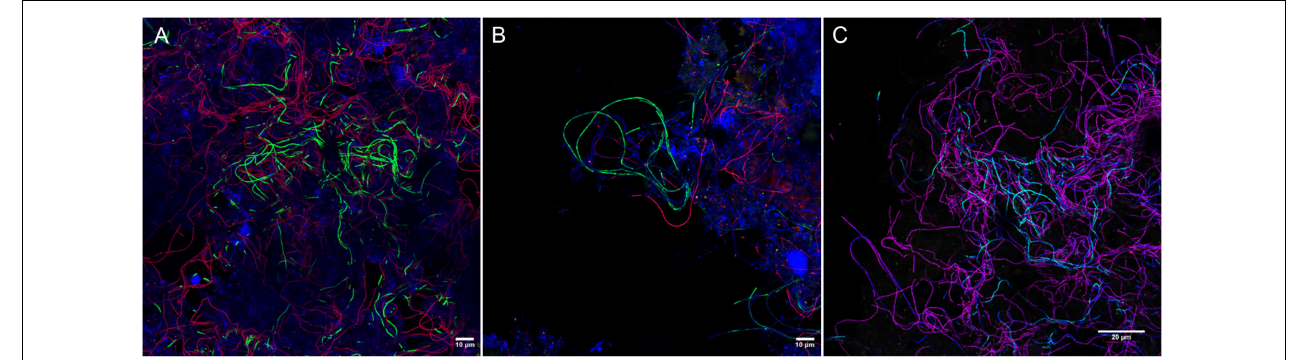
FIGURE 5 | Composite FISH micrographs of Ca. Microthrix species in full-scale activated sludge. (A) Ca. M. parvicella visualized with species-specific probes Mpa177 (Cy3, red), Ca. M. subdominans visualized with probe Msu181 (6-FAM, green), other bacteria shown with EUBmix (Cy5, blue); (B) Ca. M. parvicella visualized with species-specific probe MPA60 (Cy3, red), Ca. M. subdominans visualized with probe Msu181 (6-FAM, green), other bacteria shown with EUBmix (Cy5, blue); (C) Ca. M. parvicella visualized with species-specific probes Mpa177 (Cy3, red) appear magenta, Ca. M. subdominans visualized with probe Msu181 (6-FAM, cyan) appear white, Ca. Microthrix genus visualized with probe MCX840 (Cy5, blue). Activated sludge was sampled from Randers WWTP.